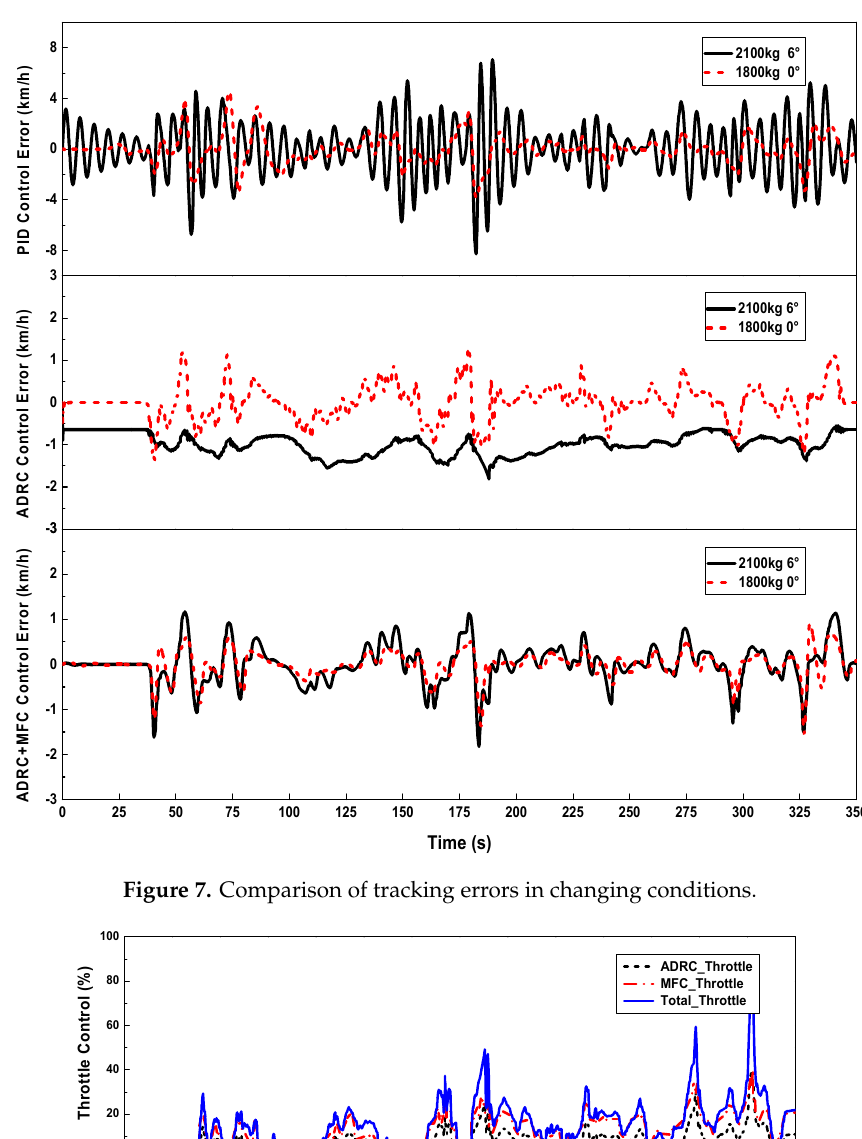
Figure 7. Comparison of tracking errors in changing conditions.